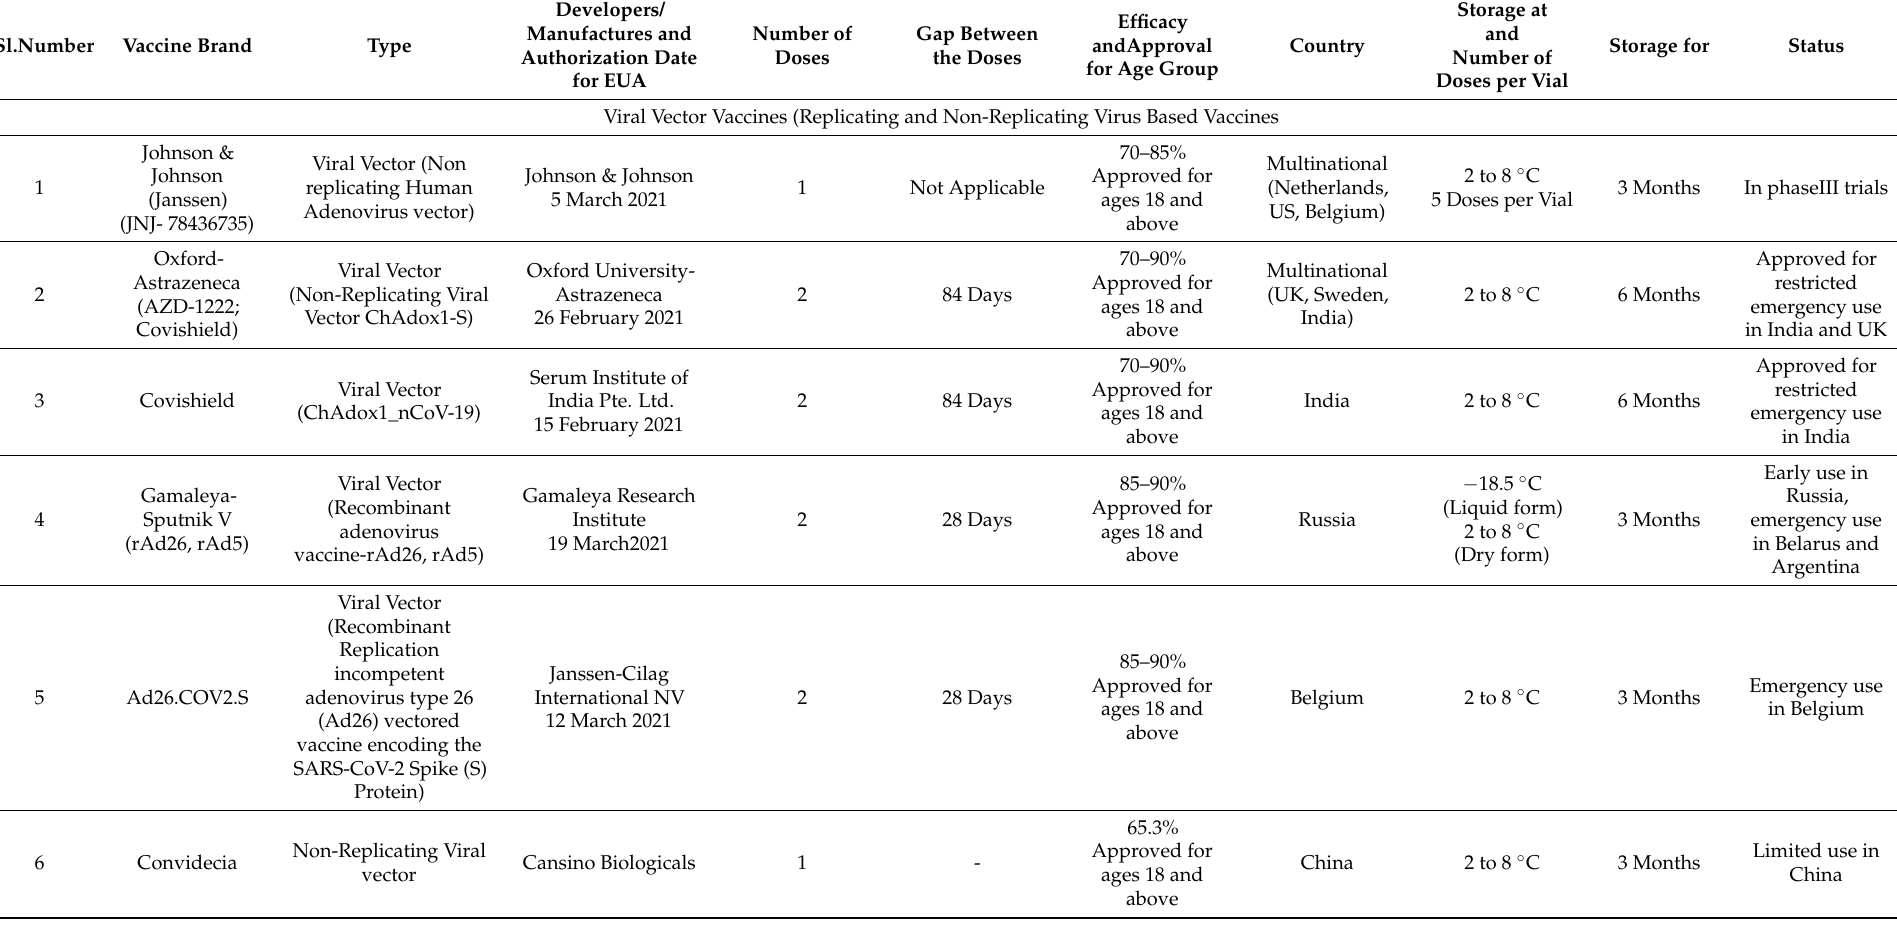
Table 2. COVID-19 Vaccines Details Enlisted with Developers/Manufacturers, Number of Doses, Efficacy, Storage, Conditional Approval, and Current Stage of Clinical Trials